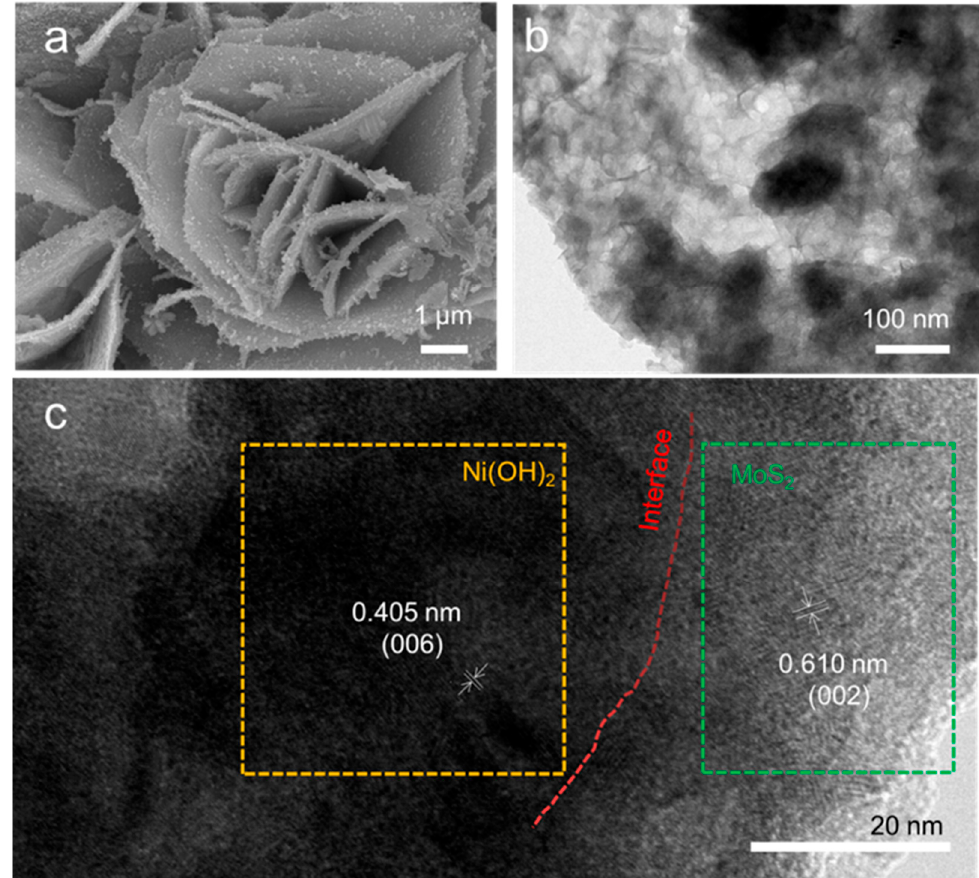
Figure 2. ( a ) SEM image, ( b ) TEM image, ( c ) HR-TEM image of the Ni(OH) 2 /MoS 2 /NF electrocata-